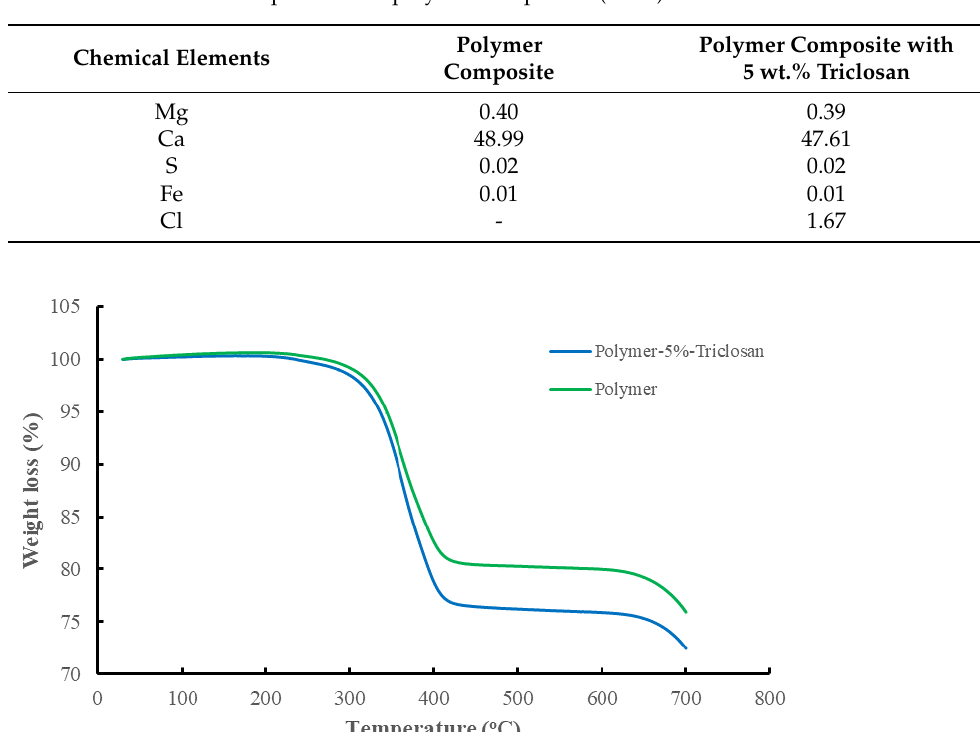
Table 5. The chemical compositions of polymer composites (wt.%).